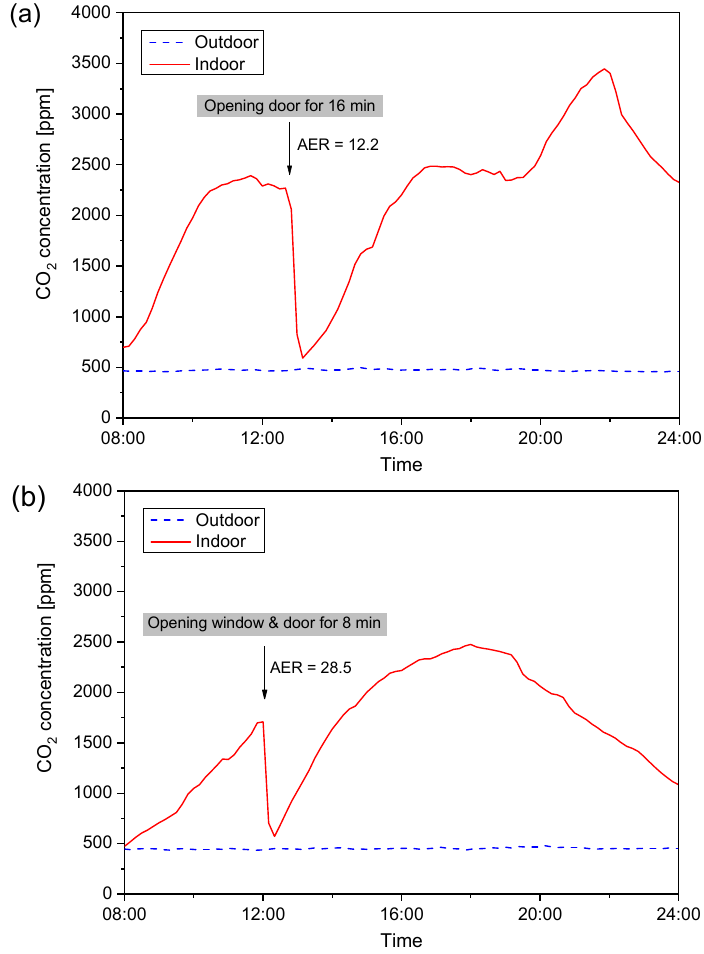
Figure 11. Indoor CO 2 concentration and door/window opening: ( a ) 24 November; ( b ) 30 November.